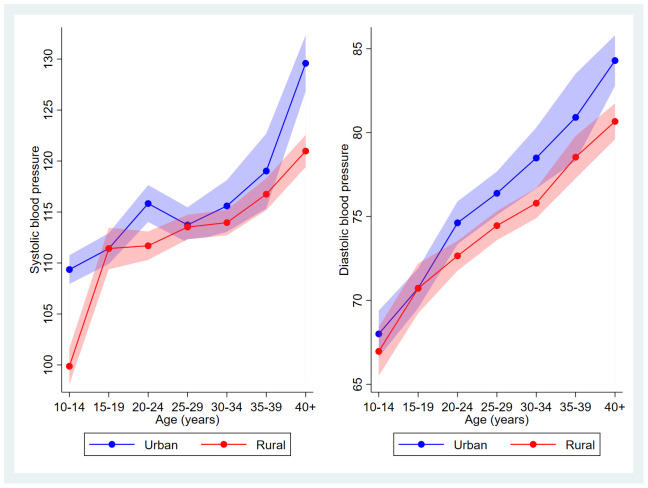
Variation of mean systolic and diastolic blood pressure with age in the rural and urban settings.The shaded areas represent 95% confidence intervals (allowing for clustering) around the mean systolic and diastolic blood pressure measurements for each age group.